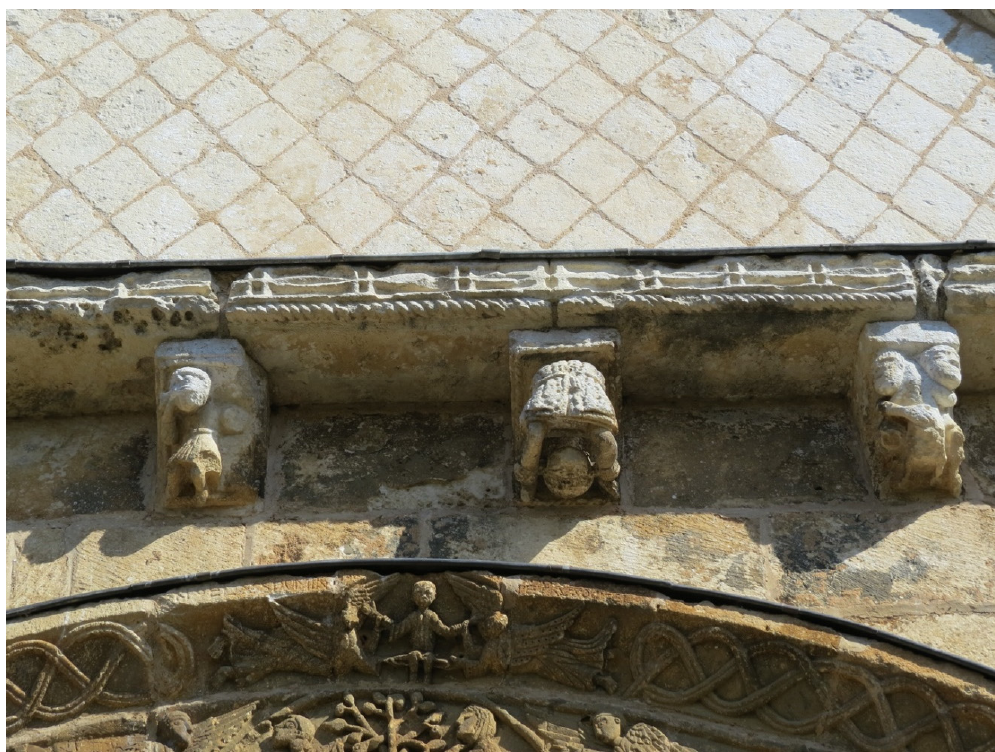
Figure 17. Corbels, detail, west façade, Saint-Martin Church , 12th c., Besse, Dordogne, Nouvelle-Aquitaine, France. ©Author.